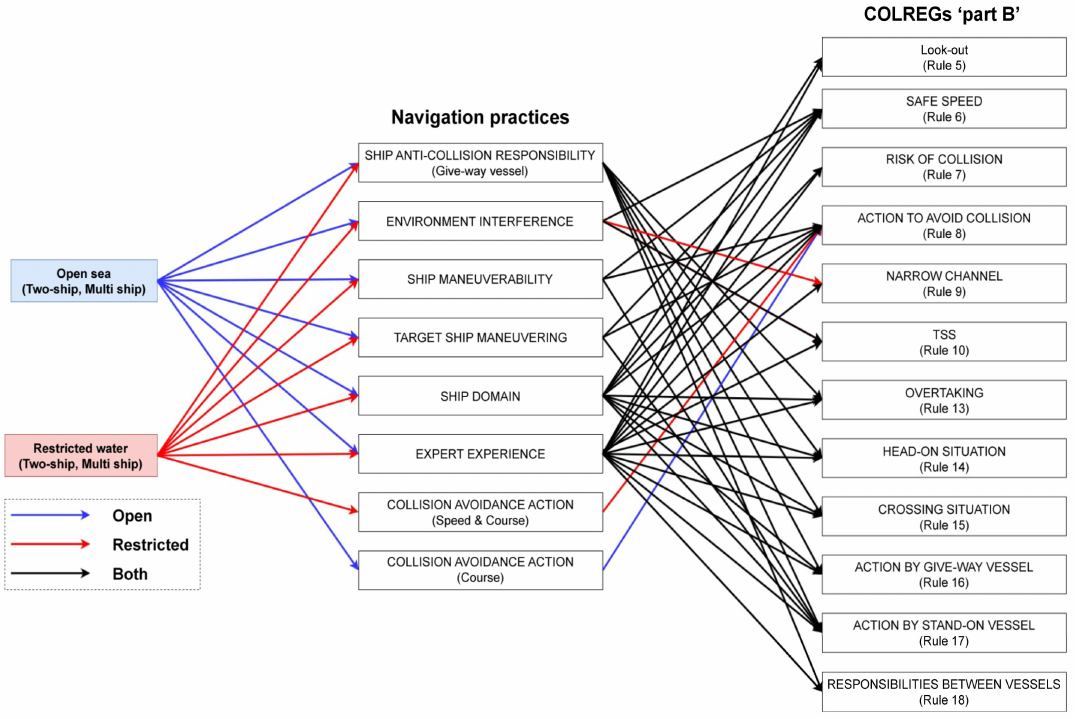
Figure 3. Classification and connection between navigation practices and COLREGs part